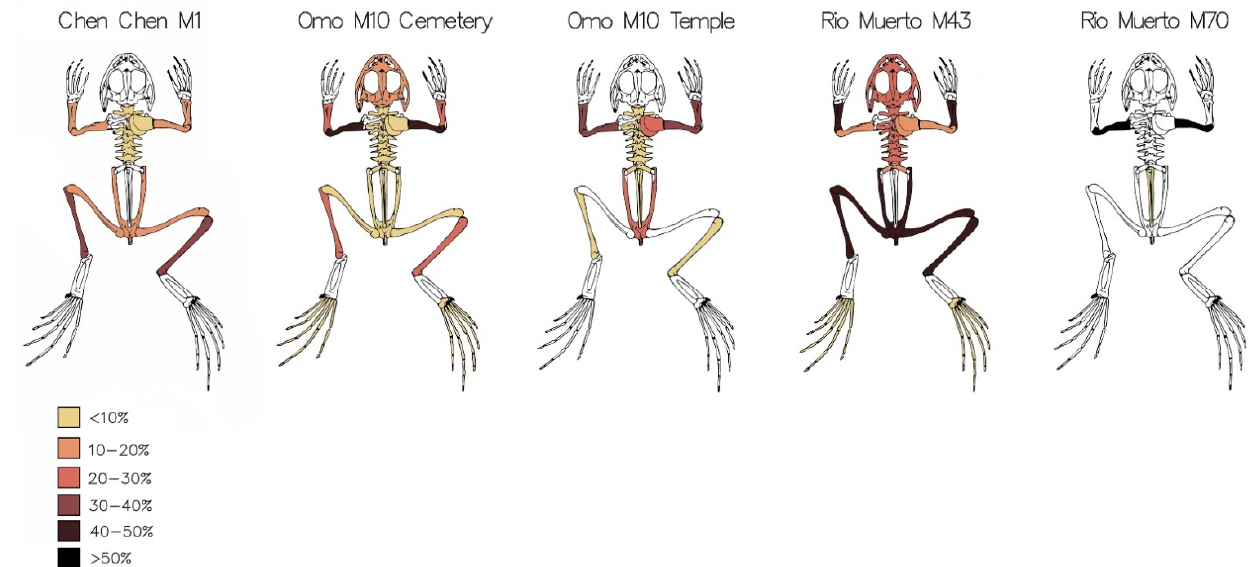
Figure 3. Diagram of anuran element relative abundance by site.